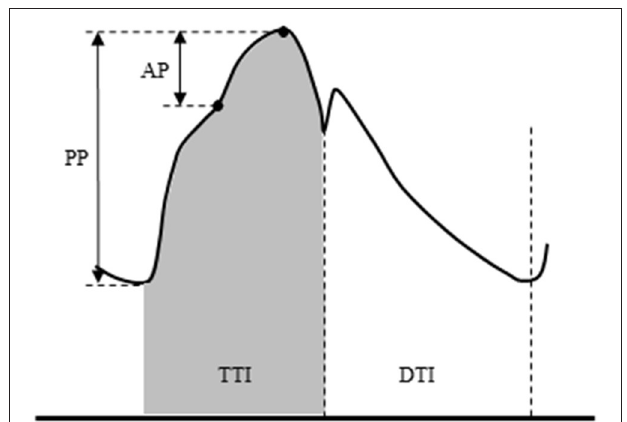
FIGURE 1 | Schema of aortic pulse wave analysis. Augmentation pressure (AP) is the difference between the first systolic peak (or shoulder) and the second systolic peak pressure. Augmentation index (AIx) is defined as the AP as a percentage of pulse pressure. The dicrotic notch (DN) represents the closure of the aortic valve and is used to calculate ejection duration. Aortic tension-time index (TTI) and diastolic pressure-time index (DTI) are areas under the aortic systolic and diastolic pressure-time curve (both measured from 0 mmHg) and reflect the myocardial oxygen demand and the blood supply to the heart, respectively. The subendocardial viability ratio (SEVR) is the ratio of DTI to TTI.